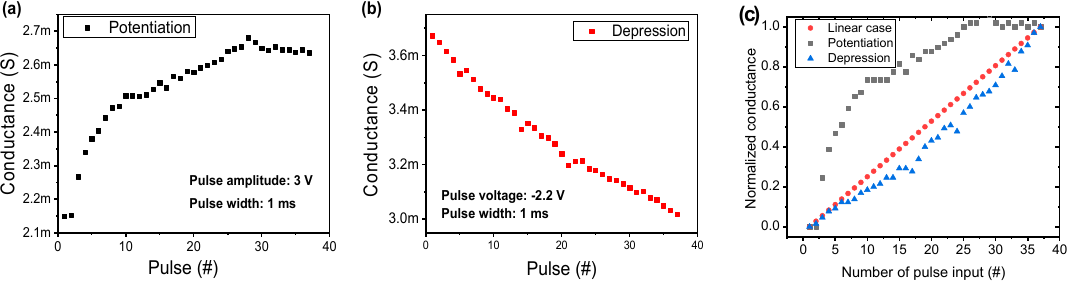
Figure 6. ( a ) Potentiation, ( b ) depression, and ( c ) normalized conductance characteristics of the Au/Ti/HfTiO x /p-Si device.